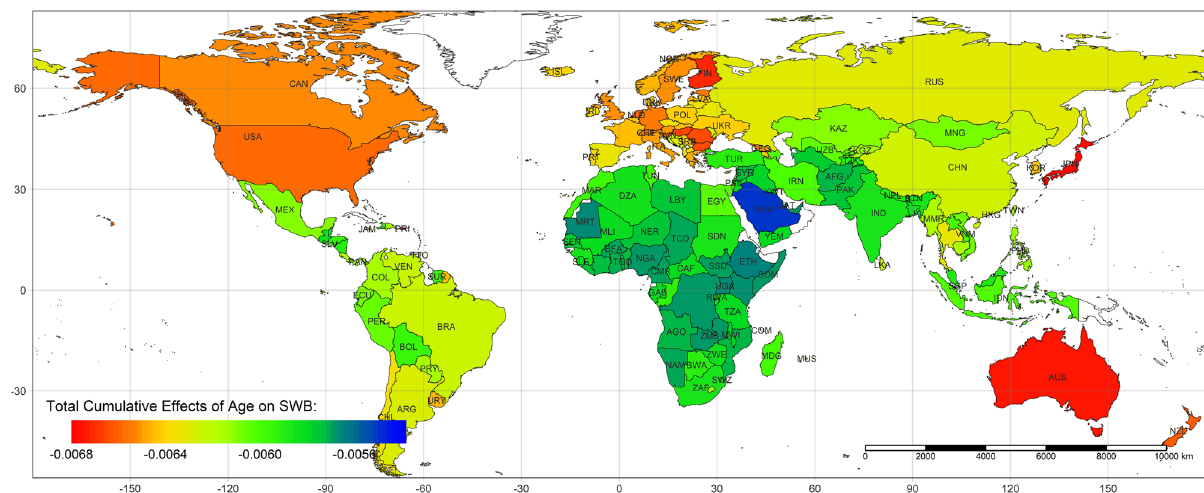
Figure 7. Map of the country-level average total cumulative effects of age on